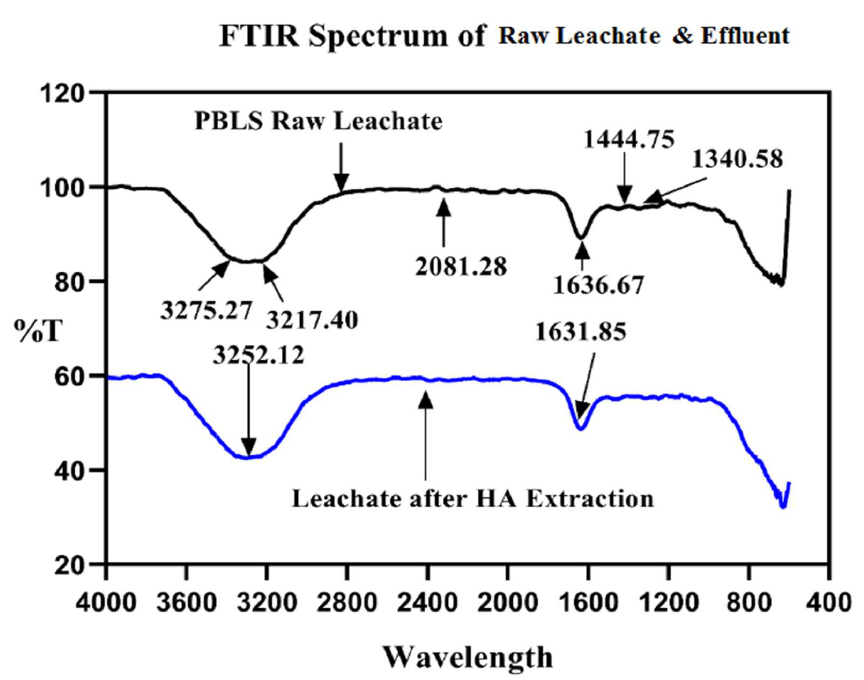
Figure 9. Differences between raw leachate and final effluent regarding humic acid isolation.